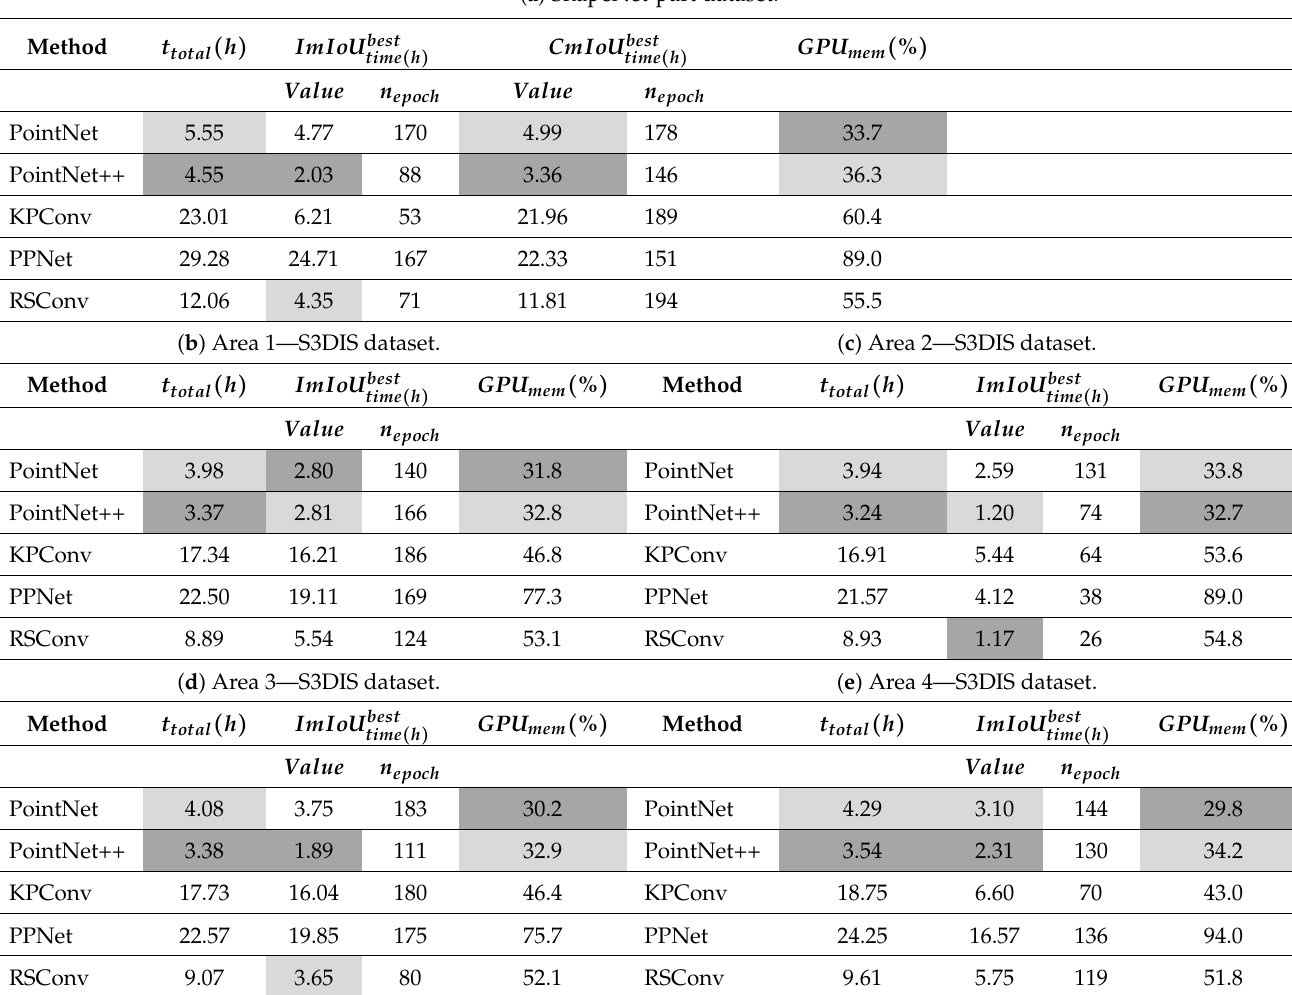
Table 6. Comparison of the efficiency of the utilized deep learning models in 200 epochs. Time values are shown in decimal hours (h). In table ( a ) we show the results utilizing the ShapeNet-part dataset and in tables ( b – g ) we show the results in all Areas of S3DIS dataset. Please note that in S3DIS, tables ( b – g ), the CmIoU values are missing, because such a performance metric is not applied in this dataset. We use dark grey and light grey cell colors to denote the best and the second best score per metric